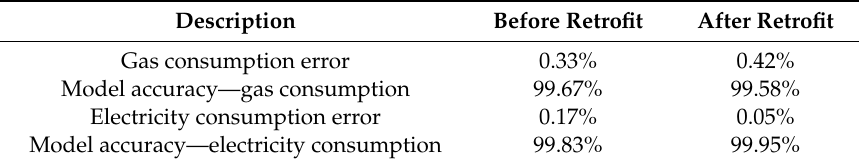
Table 8. Results of simulation model calibration before and after the